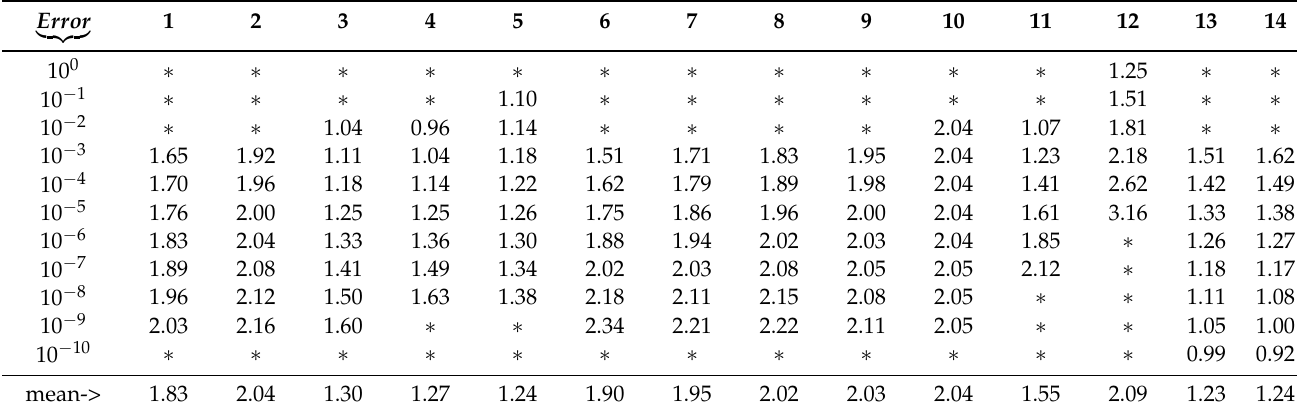
Table 6. Efficiency ratios of DP5(4) vs. NEW(4) for various problems and end-point errors achieved. Stars indicate unavailability of data to attain the perspective